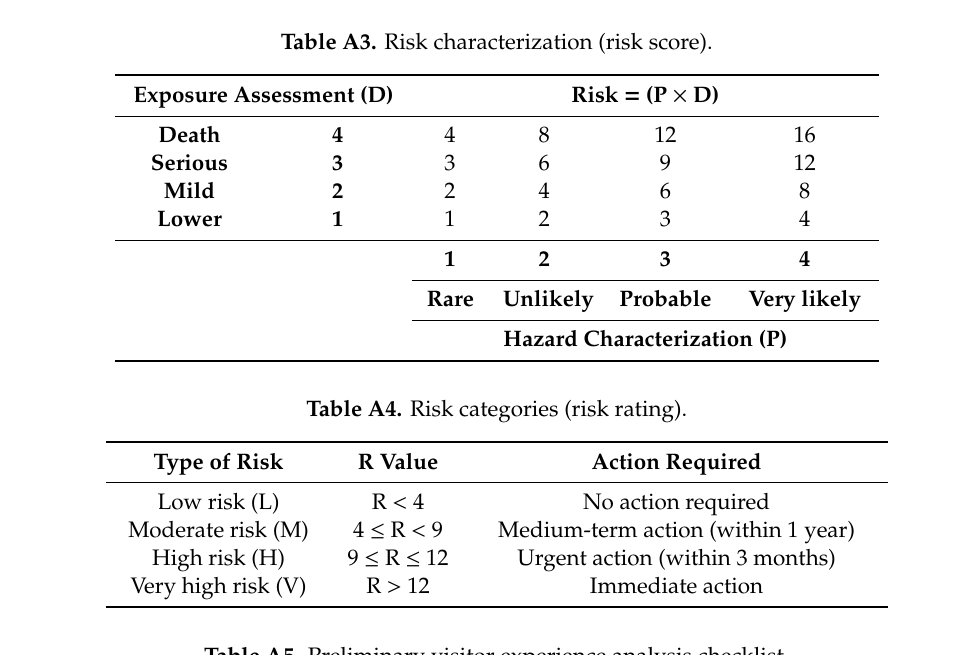
Table A5. Preliminary visitor experience analysis